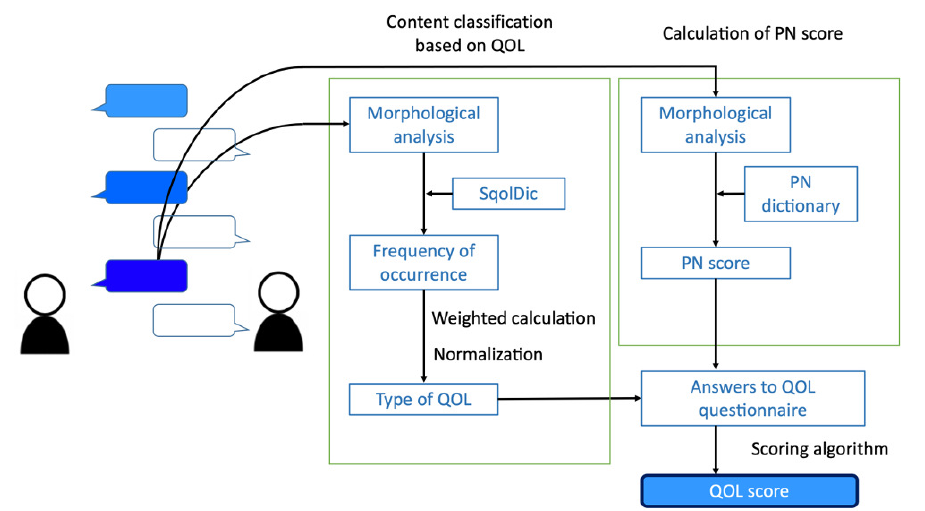
Figure 2. Text-based QOL estimation during communication. SqolDic is a QOL dictionary that we created based on large-scale textual data. PN score is a real number between − 1 and 1 that indicates whether the content is positive or negative for a given